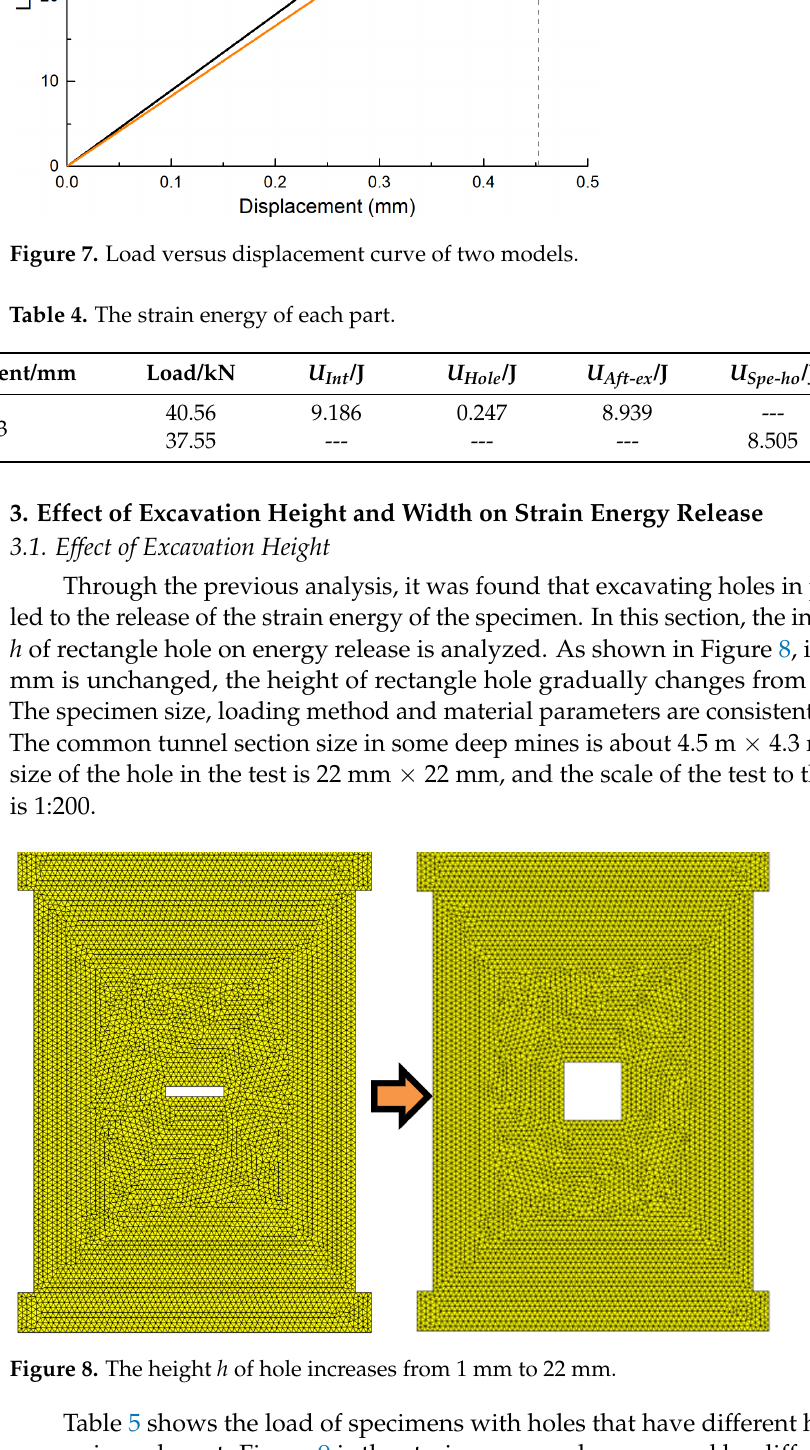
Figure 8. The height h of hole increases from 1 mm to 22 mm.